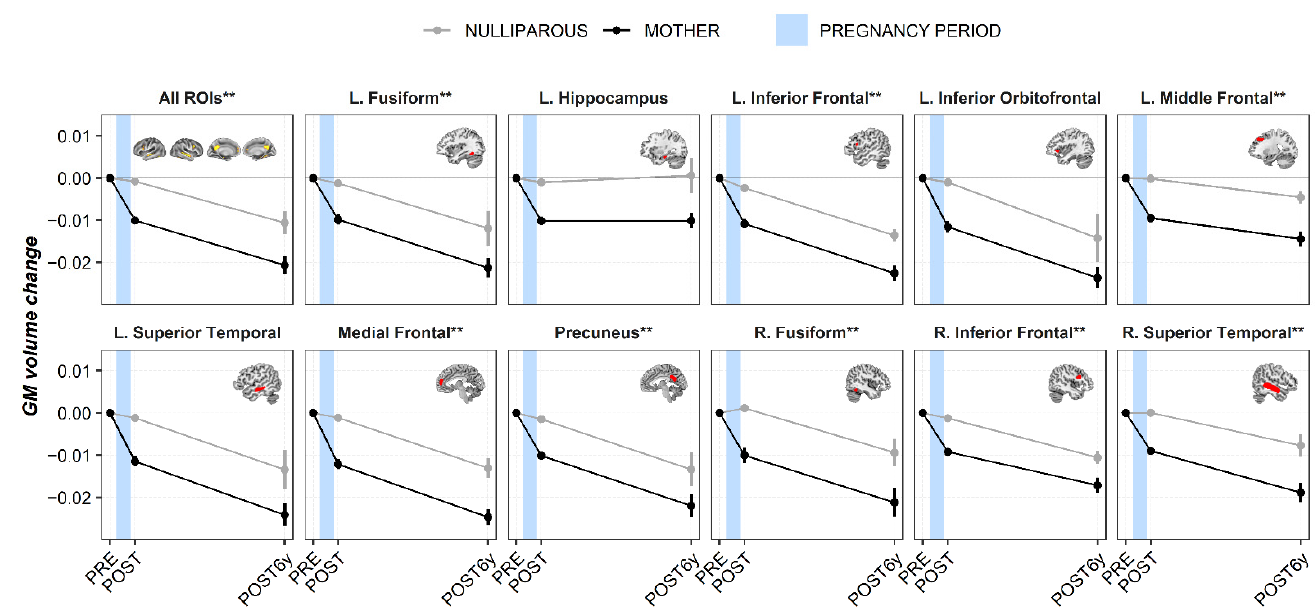
Figure 1. Gray matter volume changes for every region of interest at every session. Results of the early postpartum session were displayed as reference values [14]. Mean values (circle) with their respective standard error of the mean (vertical lines) and slopes (lines joining the circles) are represented. Black and gray lines represent mothers and nulliparous women, respectively. The blue shadow indicates the approximated period of pregnancy. Abbreviations are as follows: GM = gray matter, L. = left hemisphere, R. = right hemisphere, PRE = pre-pregnancy session, POST = early postpartum session, POST6y = six years after parturition session, and FDR = false discovery rate. ** Asterisks indicate group differences at q < 0.05 FDR-corrected for multiple comparisons.